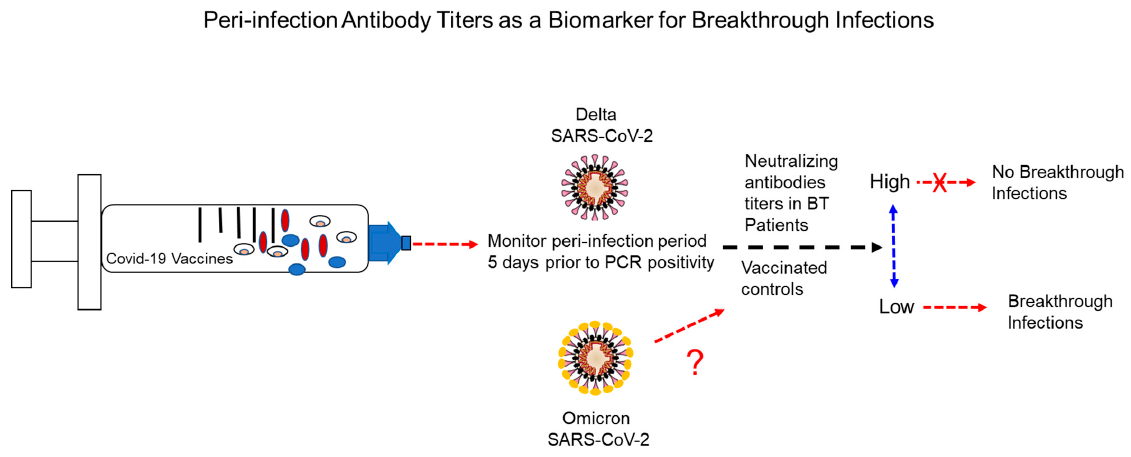
Figure 5. Peri-infection antibody titers as a potential biomarker for breakthrough infections. After the administration of FDA-approved vaccines in the US to health care workers, neutralizing antibody titers examined 5 days prior to PCR positivity (peri-infection period) compared in individu- als with breakthrough infection (BT) and vaccinated controls. Individuals with high-neutralizing antibody titers during the peri-infection period were less likely to have a breakthrough infection. The full impact of the Omicron variant on breakthrough infections is unknown.